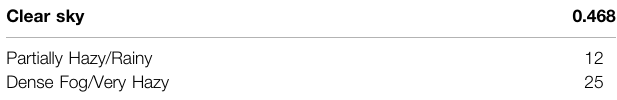
TABLE 1 | Attenuation value under different atmospheric turbulences.